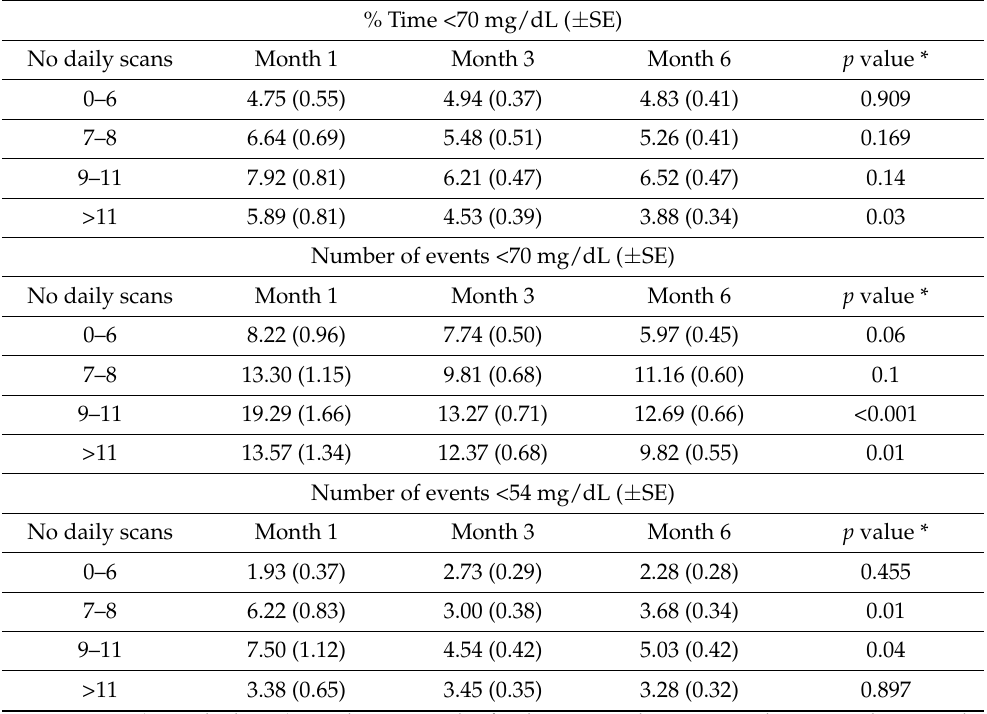
Table 2. Relationship between daily scanning rates and change in